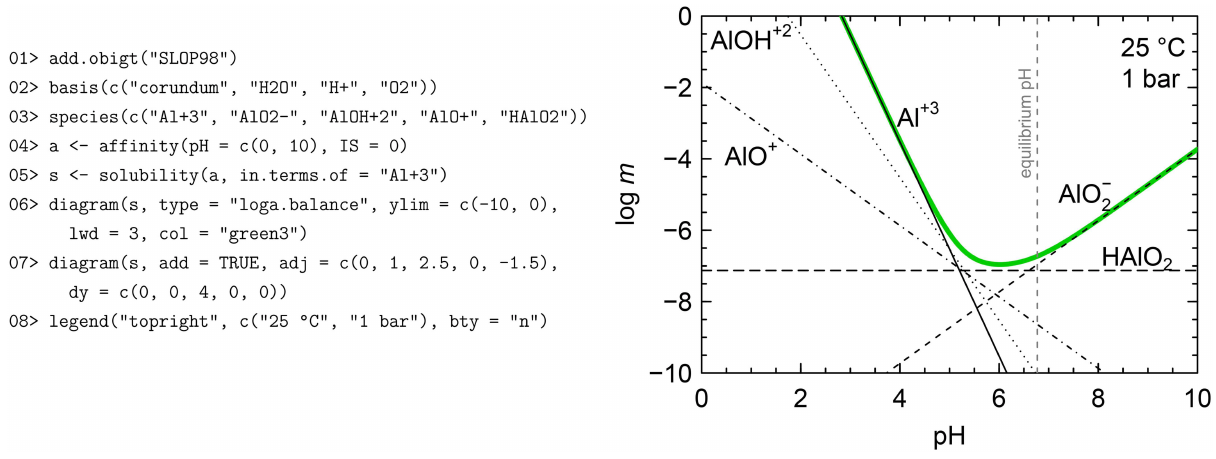
FIGURE 5 | Solubility of corundum as a function of pH. Equilibrium molalities of aqueous Al species are identified (black lines) together with the their total molality, corresponding to the solubility of corundum (green line). The vertical line shows the pH of the solution in equilibrium with corundum (dashed gray line). Thermodynamic data for corundum is from Berman (1988) and data for aqueous species are from Shock et al. (1997). The R script shown here is simplified for clarity; the complete script, which includes code to calculate and plot the pH values, is available (Dick,